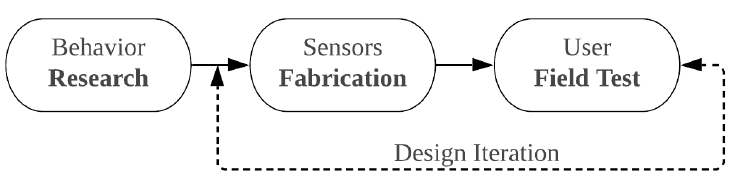
Figure 2. Research steps for the development of Presence Sticker IoT